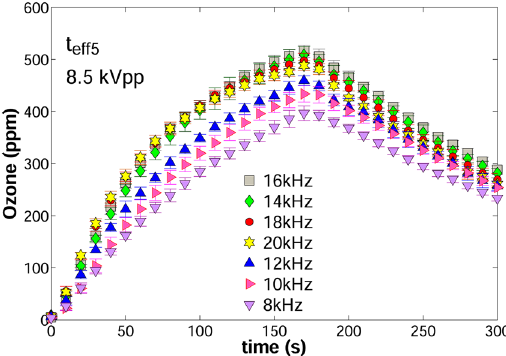
Figure 9. Curves of ozone vs. time in the frequency range 8–20 kHz. Applied voltage = 8.5 kVpp; t eff = 0.11 mm.